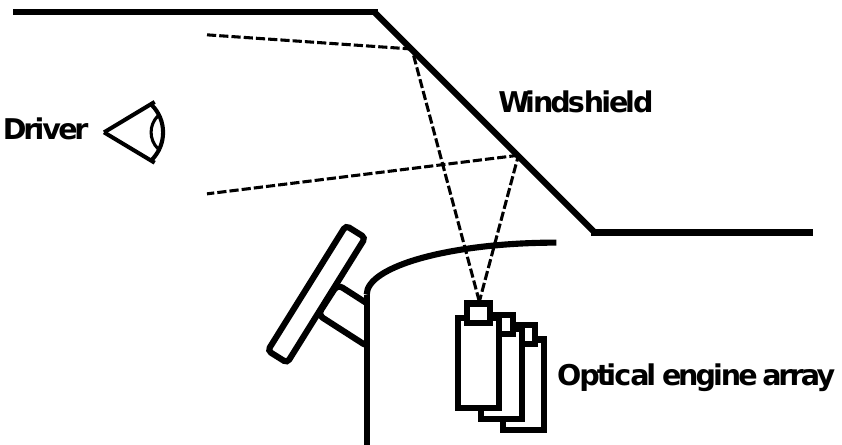
Figure 6. Concept of an onboard light field visualization system [129].